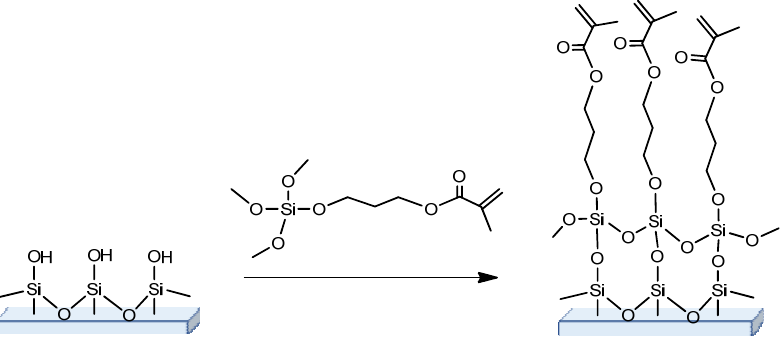
Figure 1. Scheme of the glass support silanization with the use of silane agent (usually TMSPMA) suitable for covalent attachment of macroporous polymer layer during its further polymerization.